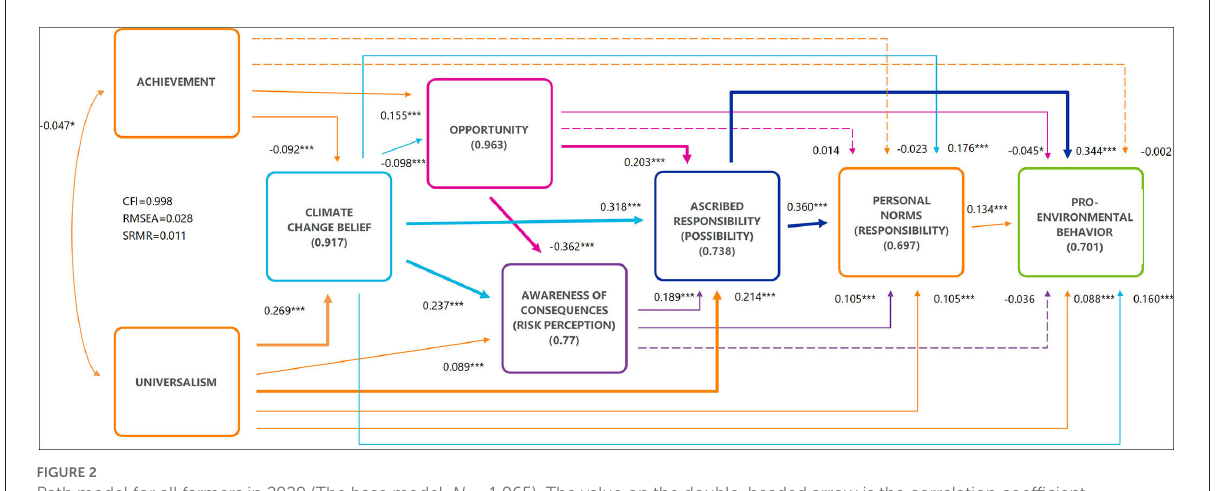
FIGURE2 Path model for all farmers in 2020 (The base model, N = 1,965). The value on the double-headed arrow is the correlation coefficient, single-headed arrows are the standardized regression coefficients, and the values in parentheses are the standardized error variances. All the parameters of relations described by solid lines differed from zero, and the relations described by dashed lines were not statistically significant. Three goodness-of-fit indices are shown in the left: CFI, comparative fit index; CI, confidence interval; RMSEA, root mean square error of approximation; SRMR, standardized root mean square residual. Statistical significance (H0:|r|=0): * p < 0.05, ** p < 0.01 and *** p <